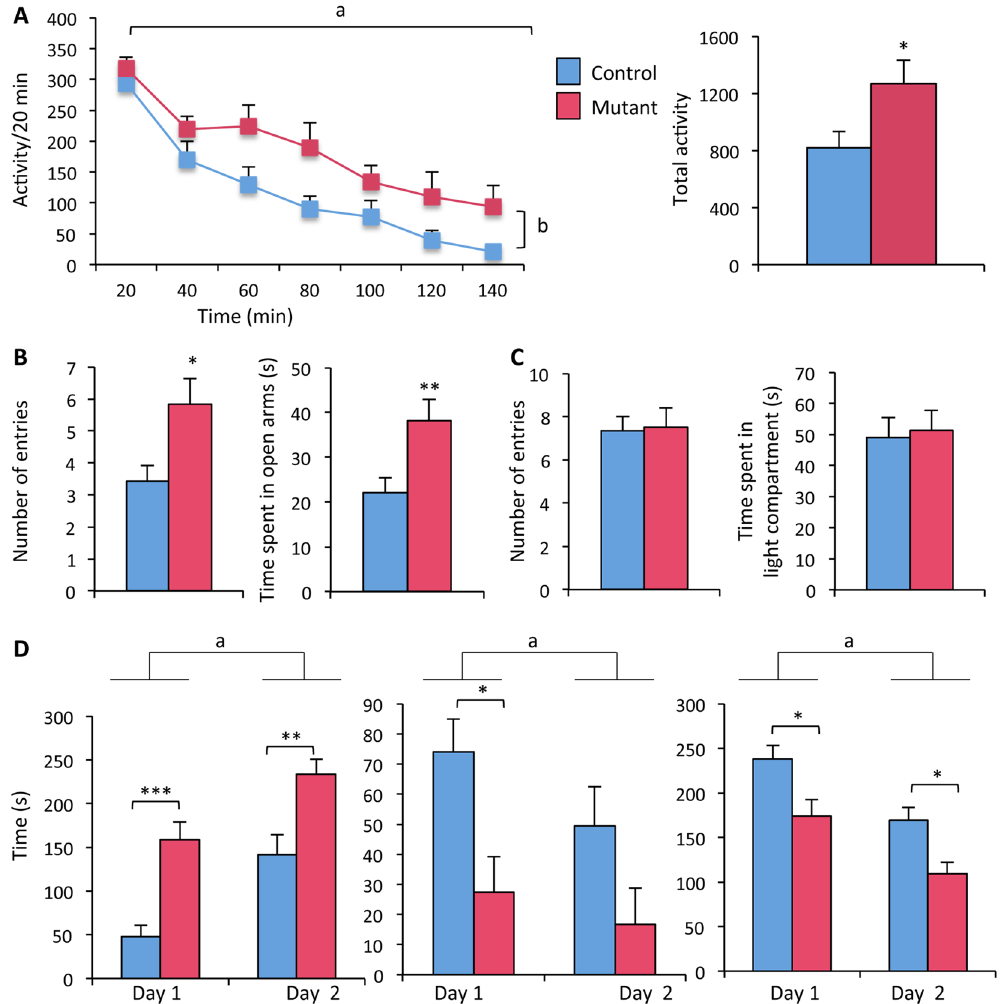
Figure 2. Effects of neural ER β knockout on locomotor activity, anxiety- and despair-like behaviors in male mice. ( A ) Left – Locomotor activity per 20 min recorded for males (n = 12–15 males per genotype). a p < 0.001: effect of time; b p < 0.05: effect of genotype with mutants more active than their control littermates. Right – Total activity measured during the 140 min of the test. * p < 0.05 versus control littermates. ( B-C ) Left – Number of entries in the open arms of the O-maze ( B ), or light compartment of the dark-light box ( C ). Right – Time spent in the open arms of the O-maze ( B ), or light compartment of the dark-light box ( C ). ( D ) Left – Time spent in immobility over two consecutive days in the forced swim test (n = 12–15 males per genotype). Two-ANOVA shows an effect of time ( a p < 0.001); post hoc analyses show increased time in immobility for mutants at day 1 ( a p < 0.001 versus control) and day 2 ( ** p < 0.01 versus control). Middle – Time spent in climbing. Two-ANOVA shows an effect of time ( a p < 0.05); post hoc analyses show reduced time in climbing for mutants at day 1 ( * p < 0. 05 versus control). Right – Time spent in swimming. Two-way ANOVA shows an effect of time ( a p < 0.001); post hoc analyses show reduced time in swimming for mutants at days 1 and 2 ( * p < 0. 05 versus